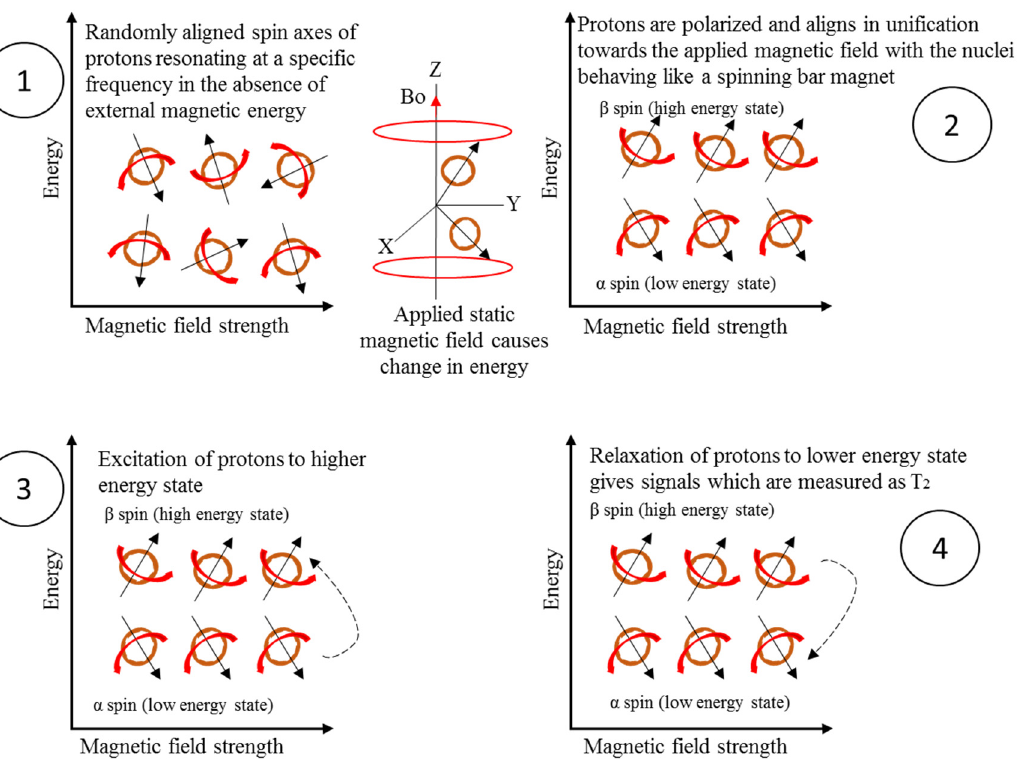
Figure 1. Polarisation of hydrogen nuclei illustrating nuclei excitation/relaxation in the presence of applied external magnetic energy.